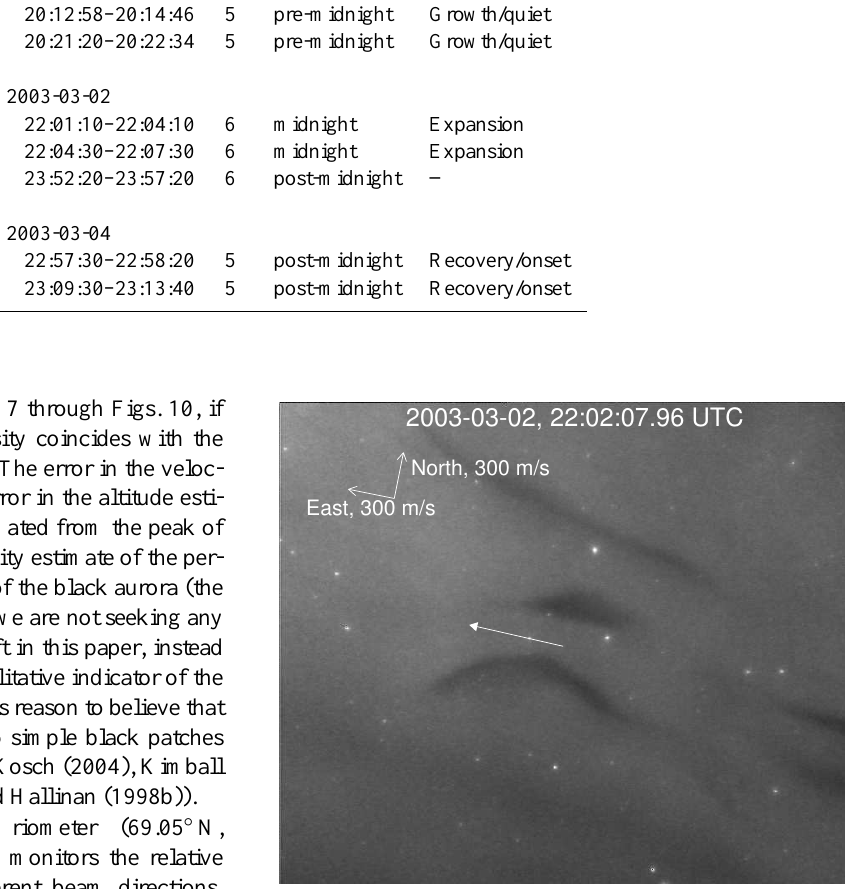
Fig. 1. An example image of the black aurora from event 03A. The velocity measured from the EISCAT radar is shown as a vector near the center. Note how the black structures are aligned with the plasma velocity